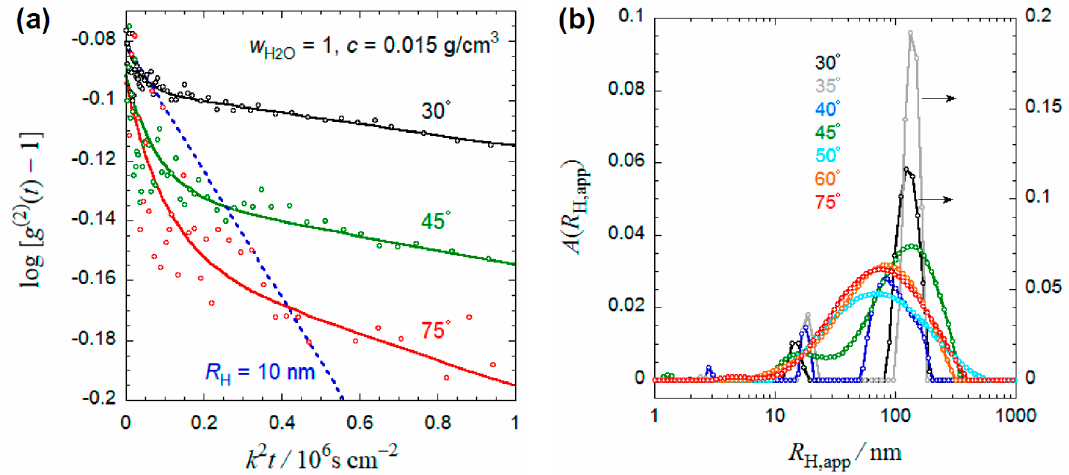
Figure 3. Dynamic light scattering (DLS) results for a PFSI solution with w H 2 O = 1 and c = 0.015 g/cm 3 .